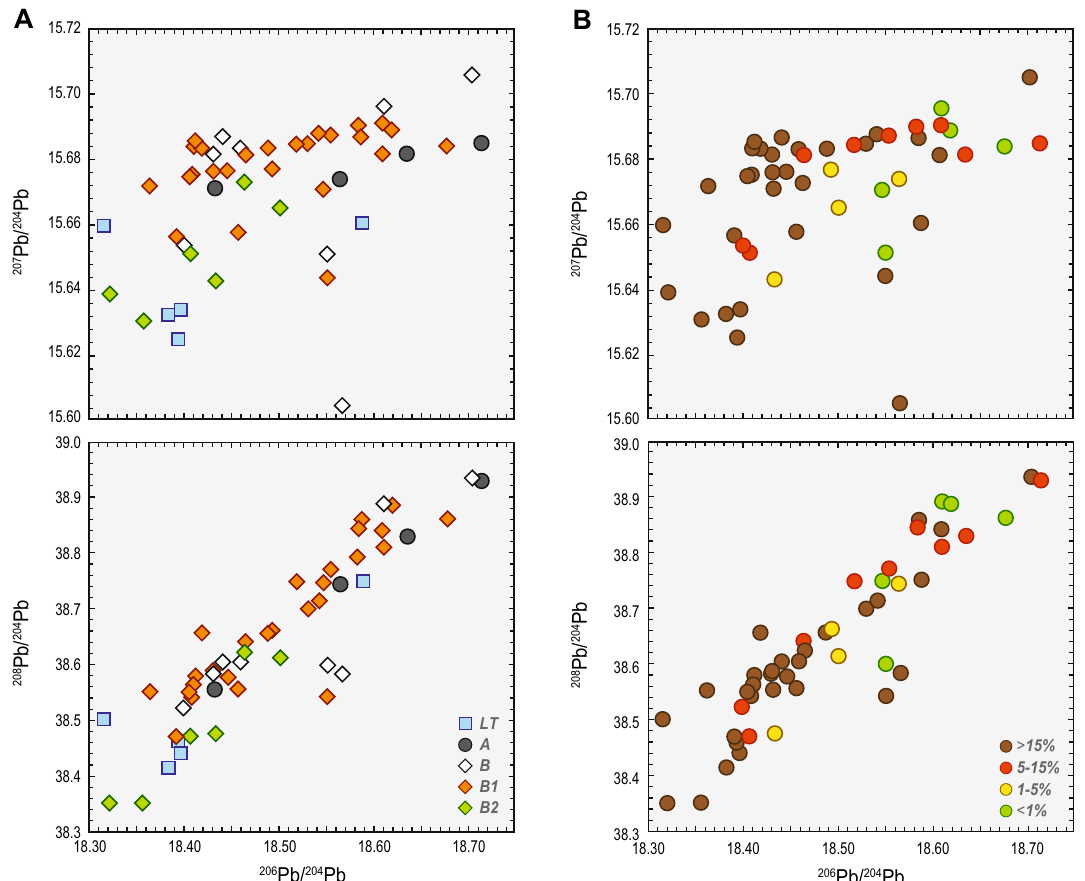
Figure 5. The Pb isotope systematics of the Bohemian brass artefacts from this study categorised according to the archaeological dating ( A ) and Zn contents ( B ). For categorisation according to the cultural groups see Fig.